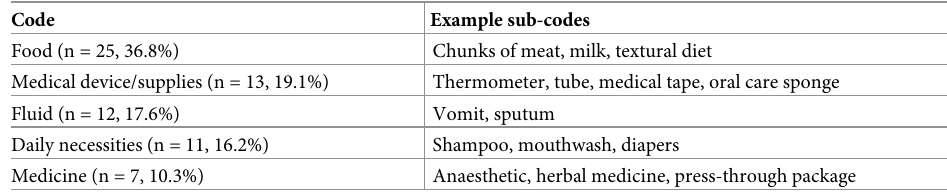
Table 3. Physical contributory factors for choking.